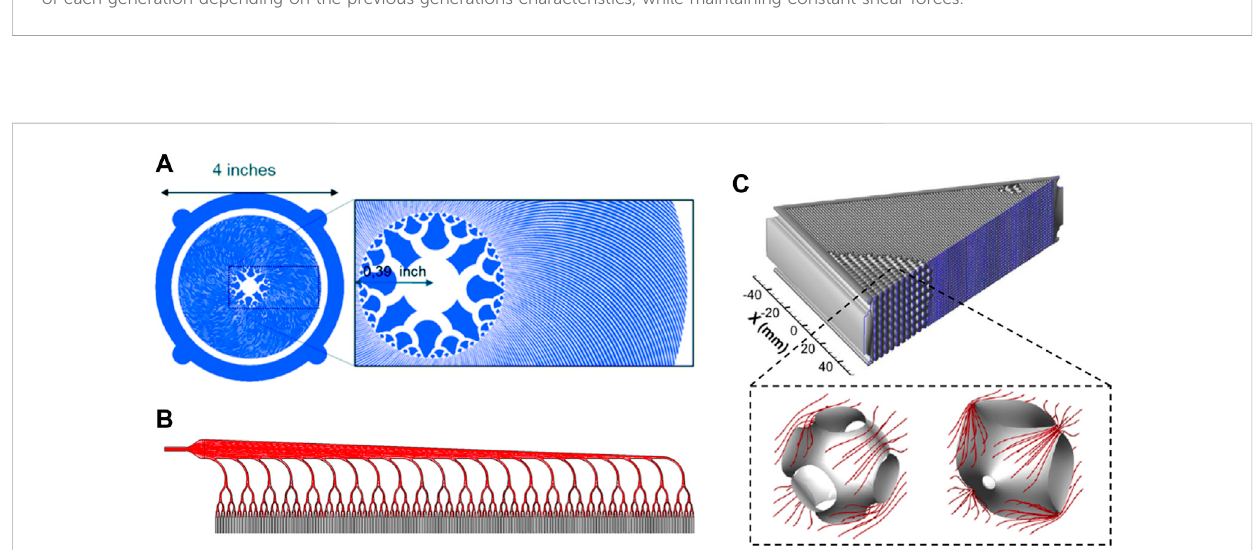
Biomimetic approaches in oxygenators design. (A, B) present two different blood distribution methods in micro fl uidic oxygenators allowing for a progressive scale reduction of the microchannels. (C) details a TPMS-based membrane oxygenators whose modules have been optimised upon